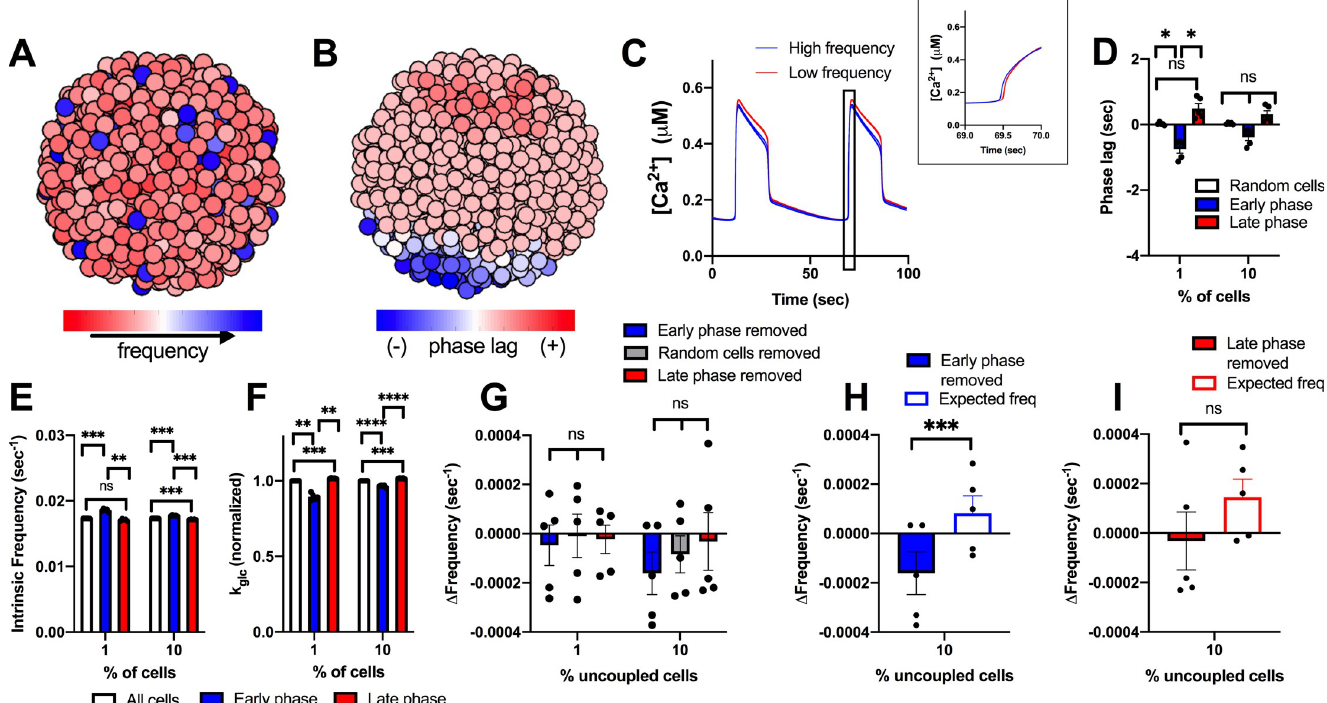
Fig 6. Simulations predicting how cells from a bimodal distribution characterized by early phase cells contribute to islet frequency. A). Schematic of frequency across simulated islet with a bimodal distribution in GK activity. B). Schematic of phase lag across simulated islet with a bimodal distribution in GK activity. C). Representative time courses of [Ca 2+ ] for 6 cells in simulated islet in A (and B) in a simulation with full (120pS) coupling conductance. Blue traces are high frequency cells, red traces are low frequency cells. Inset: Close up of rise of [Ca2+] oscillation showing phase lags. D). Phase lag from islet average of top 1% or 10% of early phase, late phase cells, or random cells. E). Average intrinsic oscillation frequencies of all cells and 1% or 10% of early phase cells, or 1% or 10% of late phase cells when re-simulated in the absence of gap junction coupling (0pS). F). Average k glc from all cells and top 1% or 10% of early phase cells or late phase cells across simulated islet (normalized to average k glc ). G). Change in frequency of islet with indicated populations removed with respect to control islet with all cells present. H). Change in frequency when early phase cells are removed compared to average oscillation frequency of remaining cells that indicates the expected oscillation frequency. I). Same as H. but for simulations where late phase cells are removed. Repeated measures one-way ANOVA with Tukey post-hoc analysis was performed for simulations in D-G and a Student’s paired t-test was performed for H and I to test for significance. Error bars are mean ± s.e.m. Significance values: ns indicates not significant (p > .05), � indicates significant difference (p < .05), �� indicates significant difference (p < .01), ��� indicates significant difference (p < .001), ���� indicates significant difference (p < .0001). Data representative of 5 simulations with differing random number seeds. Random removal of cells across the islet was used where random cells removed is